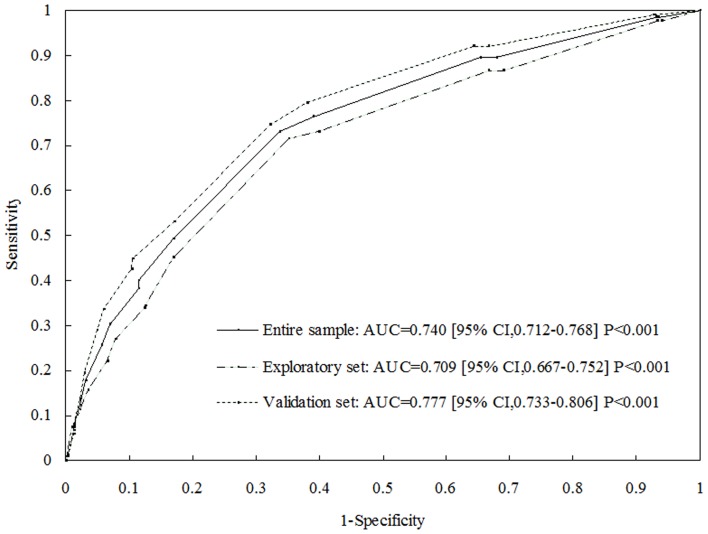
Receiver operating characteristic curves showed the performance of each cardiovascular autonomic neuropathy (CAN) risk score (CRS) in predicting prevalence of diabetes in the exploratory, validation and entire cohorts.The 95% confidence interval (CI) is given in parentheses. AUC - area under the curve.